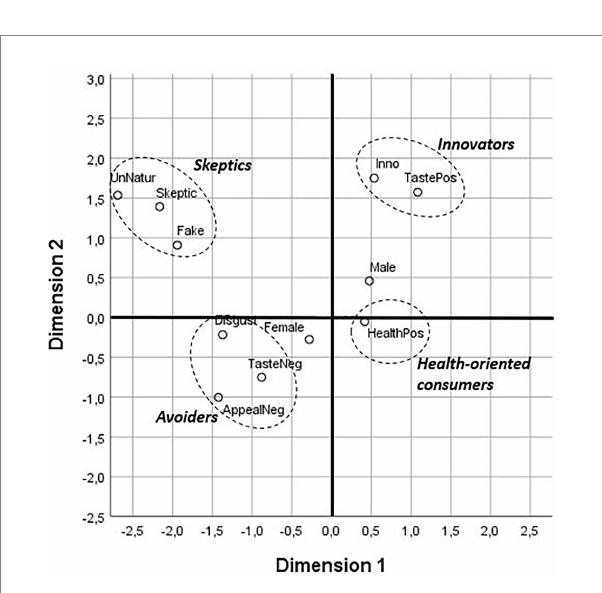
FIGURE 2 Biplot of the relationships between mental associations with meat